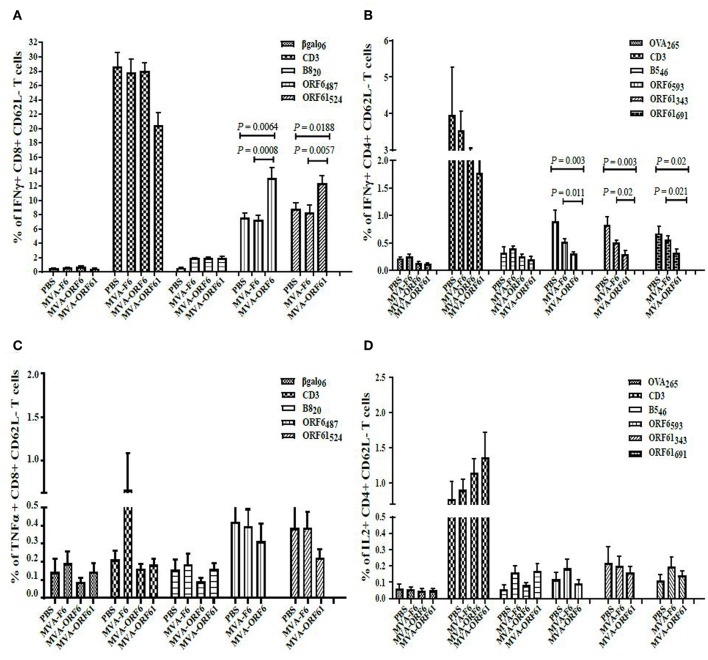
CD8+ and CD4+ T cell responses in recMVA-prime/boost vaccinated mice 17 days after MHV-68 challenge. (A) Detection of activated (CD62L−) IFNγ- or (C) TNFα-producing ORF6- and ORF61-specific CD8+ T cells (ICS followed by FACS analysis). Splenocytes were stimulated with peptide epitopes ORF6487/ORF61524, βgal499 (negative control) or B820 (vaccination control). (B) Detection of activated (CD62L-) IFNγ- or (D) IL2-producing ORF6- and ORF61-specific CD4+ T cells. Splenocytes were stimulated with peptide epitopes ORF6593, ORF61343-, ORF61691, OVA265 (negative control) or B546 (vaccination control). (A–D) CD3 indicates T cell stimulation using anti-CD3 antibodies as non-antigen-specific positive control. The statistical significance was calculated using an un-paired t-test. Data shown are mean ± SEM of n = 11 mice for each group, pooled from three independent experiments.